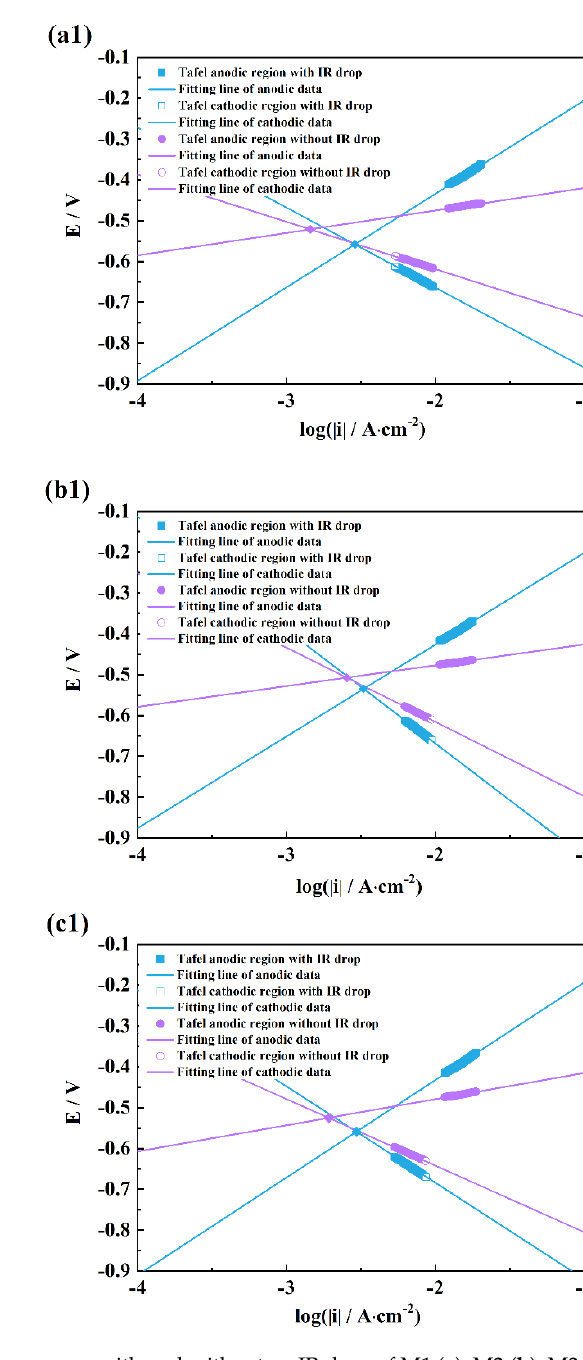
Figure 5. Comparison of polarization curves with and without an IR drop of M1 ( a ), M2 ( b ), M3 ( c ) and linear fitting plots of the Tafel regions of M1 ( a1 ), M2 ( b1 ), M3 ( c1 ) in H 2 SO 4 solutions after 2 h exposure.